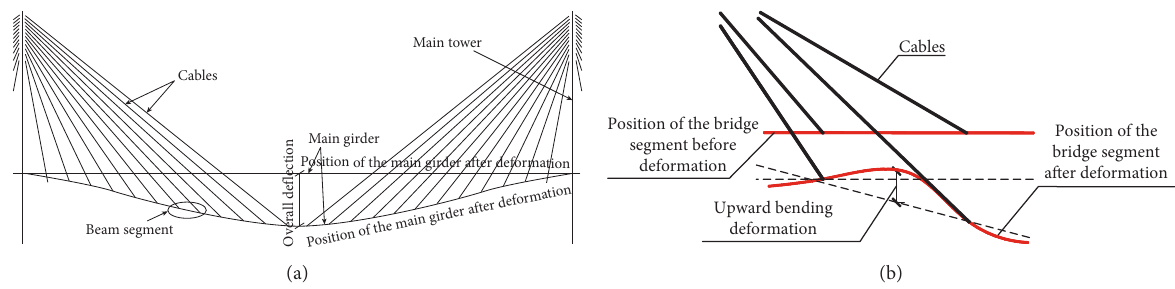
Figure 7: Deformation characteristics of the cable-stayed bridge. (a) The overall deflection of the main girder. (b) The local deformation of the beam segment.